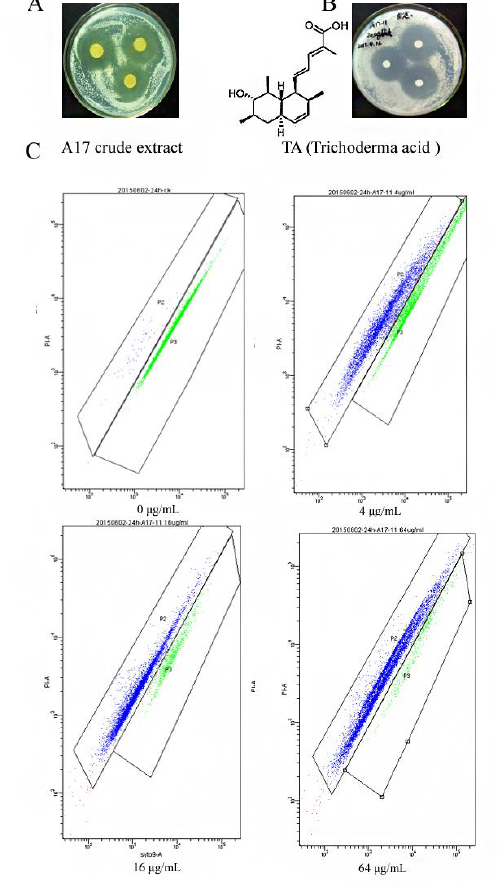
Figure 1. The anti- C. albicans effect of the extract from Trichoderma spirale and TA: ( A ) inhibitory effect of Trichoderma spirale A17 extract; ( B ) inhibitory effect of TA; ( C ) flow cytometry assay of the MIC of TA towards C. albicans. The results indicate the anti-candidal effect of the crude extract and TA. Additionally, the MIC 50 value of TA was calculated by SigmaPlot.